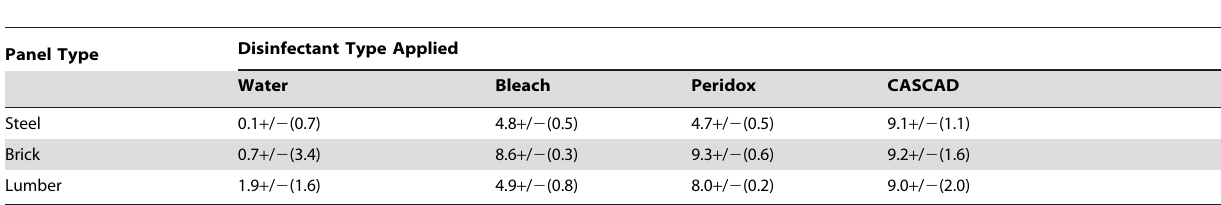
Table 3. Log10 reduction after initial decon application of decontamination solution